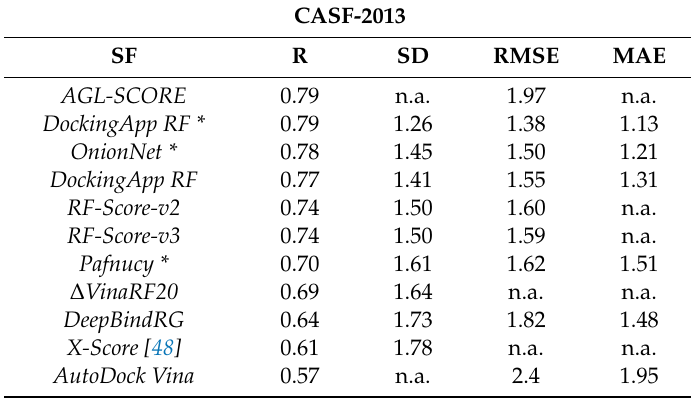
Figure 3. Performance comparison between DockingApp RF’s and AutoDock Vina’s scoring functions on the CASF-2013 and CASF-2016 benchmarks. Table 3. Performance comparison of di ff erent scoring functions on CASF-2013 and CASF-2016. Scoring functions marked with * used as a training set the PDBBind general set. R: Pearson’s correlation coe ffi cient, SD: standard deviation, RMSE: root mean squared error and MAE: mean absolute error. SF: scoring